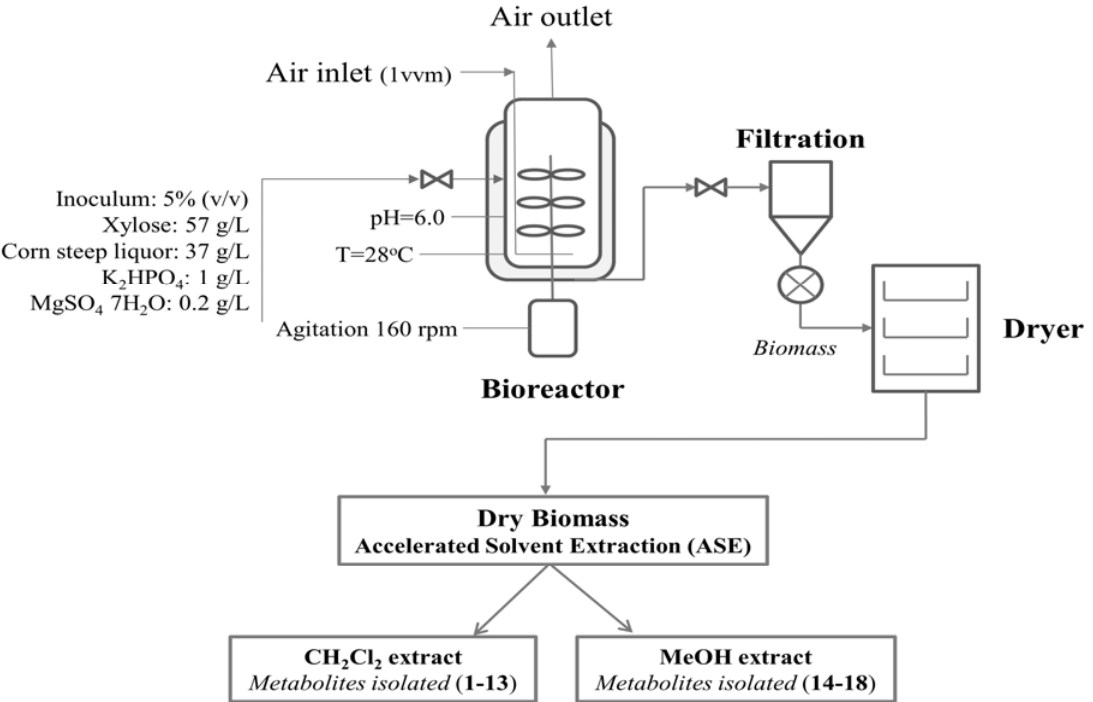
Figure 4. Flow diagram of conventional batch reactor system for maximum biomass production of P.